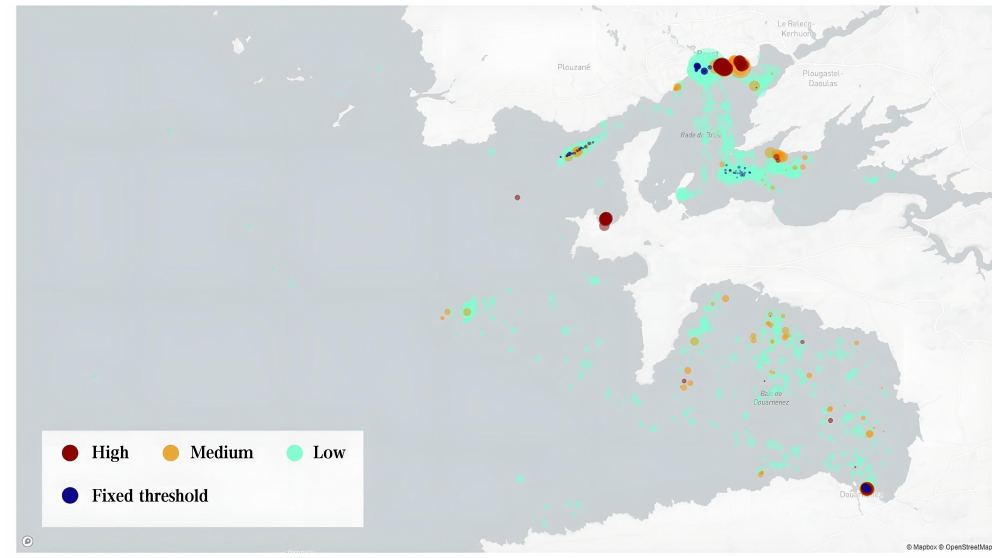
Figure 6. Visualization of suspected illegal transshipment identification results.